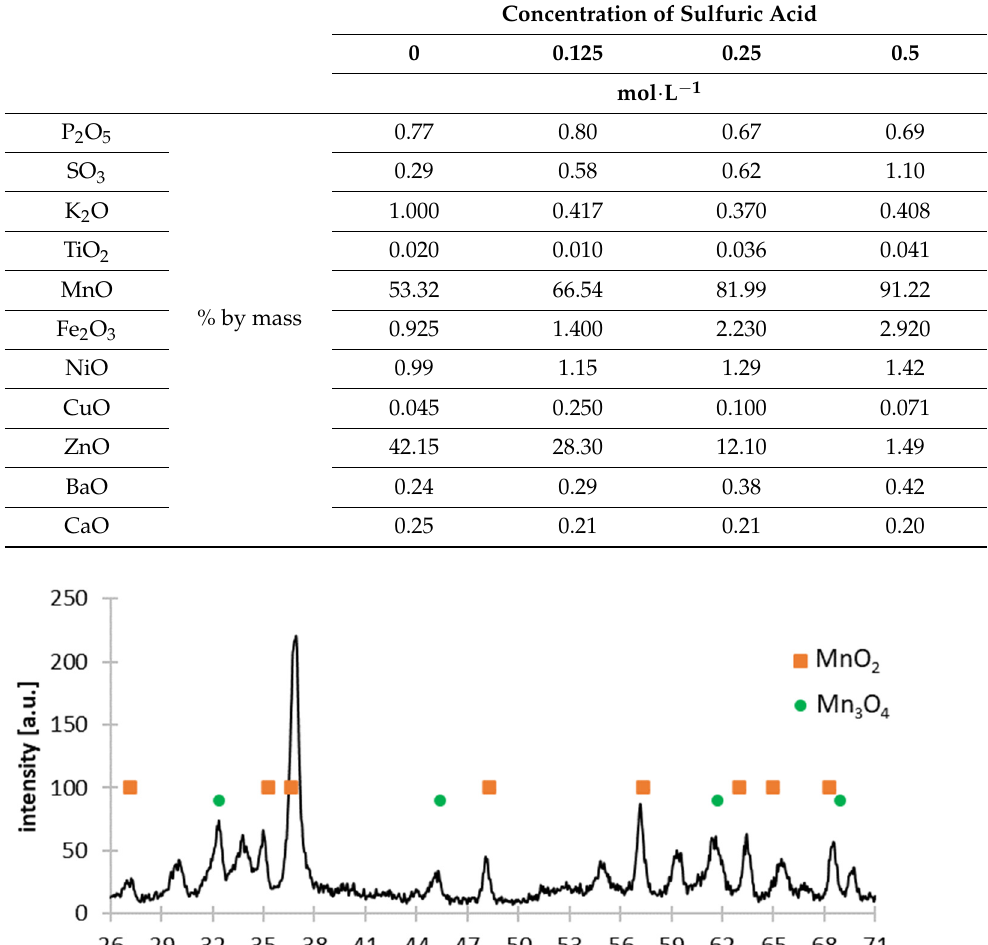
Table 3. Chemical composition of solid residues as a result of selective leaching of black mass.